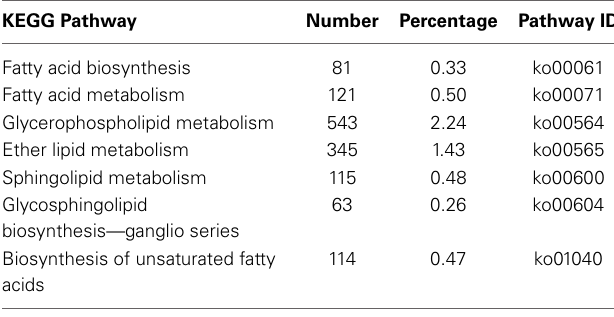
Table 2 | Summary of N. benthamiana contigs related to different lipid pathways identified by KEGG pathway